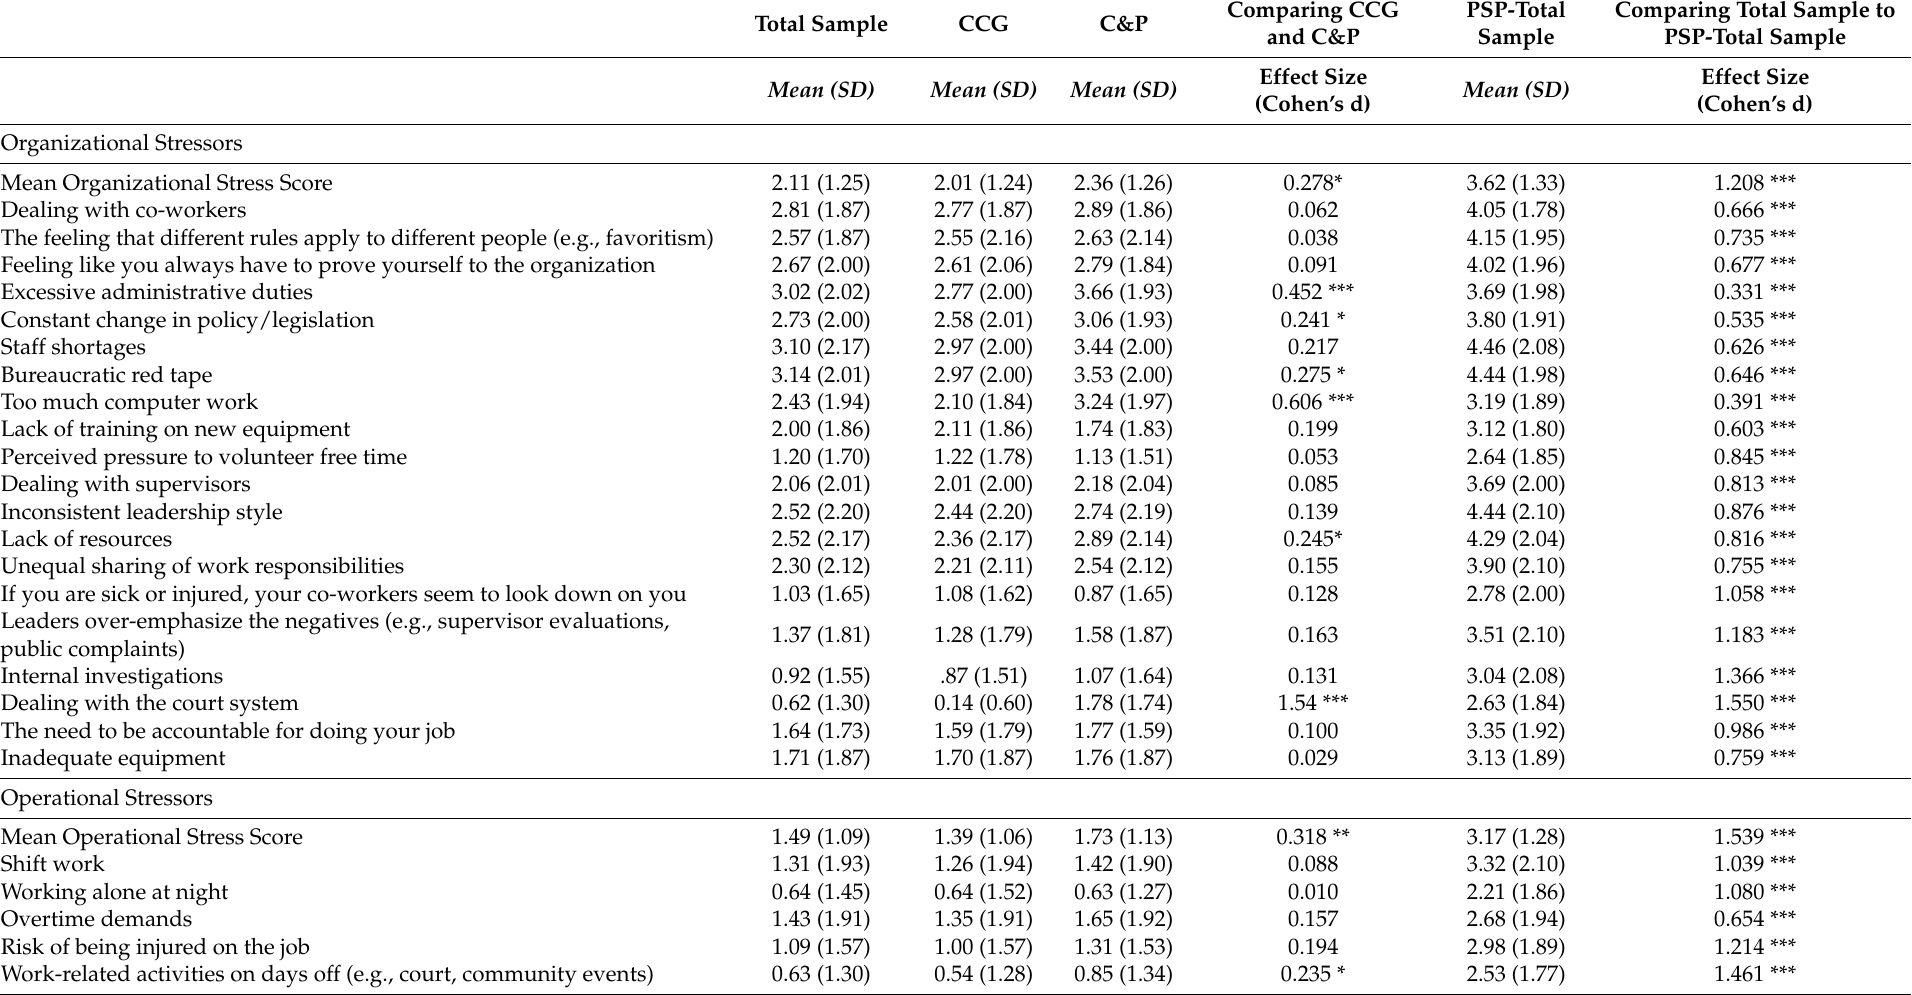
Table 3. Average Stress Levels Associated with Occupational